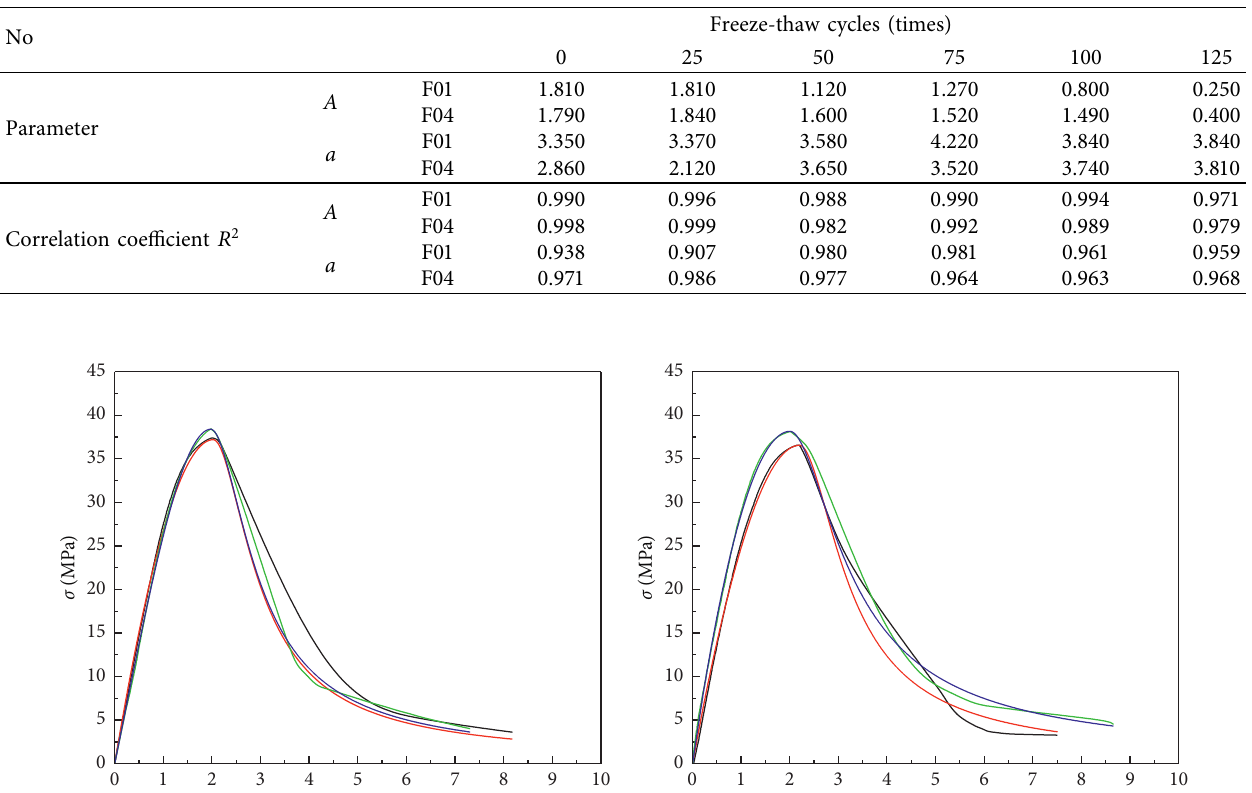
Table 6: Parameters A and a of OC and DSC with 50%